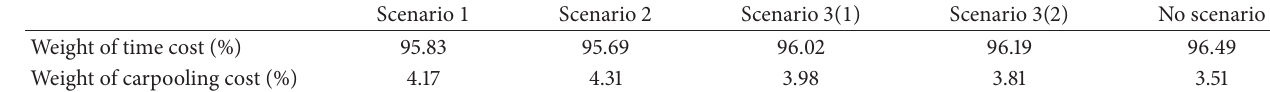
Table 6: Weight effects on components of total travel costs under the